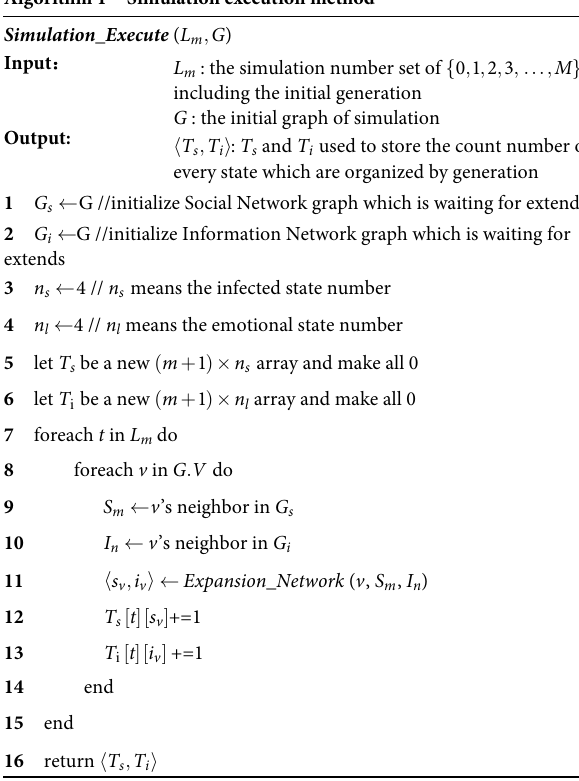
Algorithm 1 Simulation execution